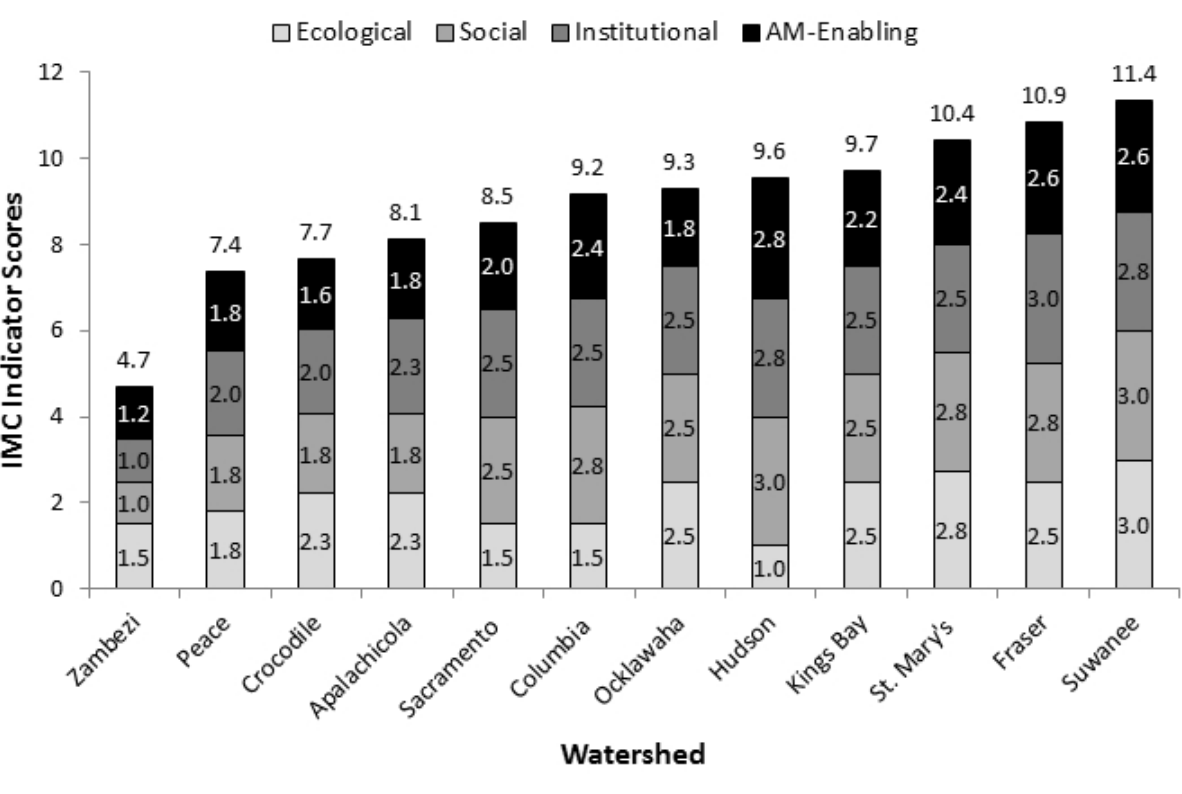
Fig. 2 . IMCs with averaged indicator category scores for the twelve watersheds in this study. Possible scores for each indicator category range from 1.0 to 3.0. The number above each bar is the final IMC score for the watershed, calculated as the sum of its four category